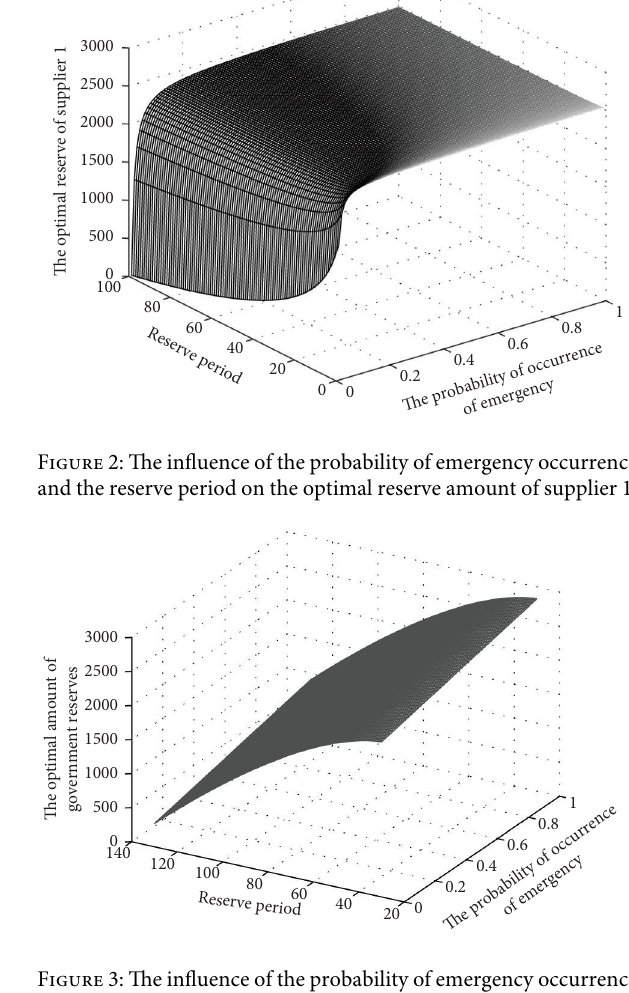
Figure 3: Te infuence of the probability of emergency occurrence and reserve period on the optimal government reserve.